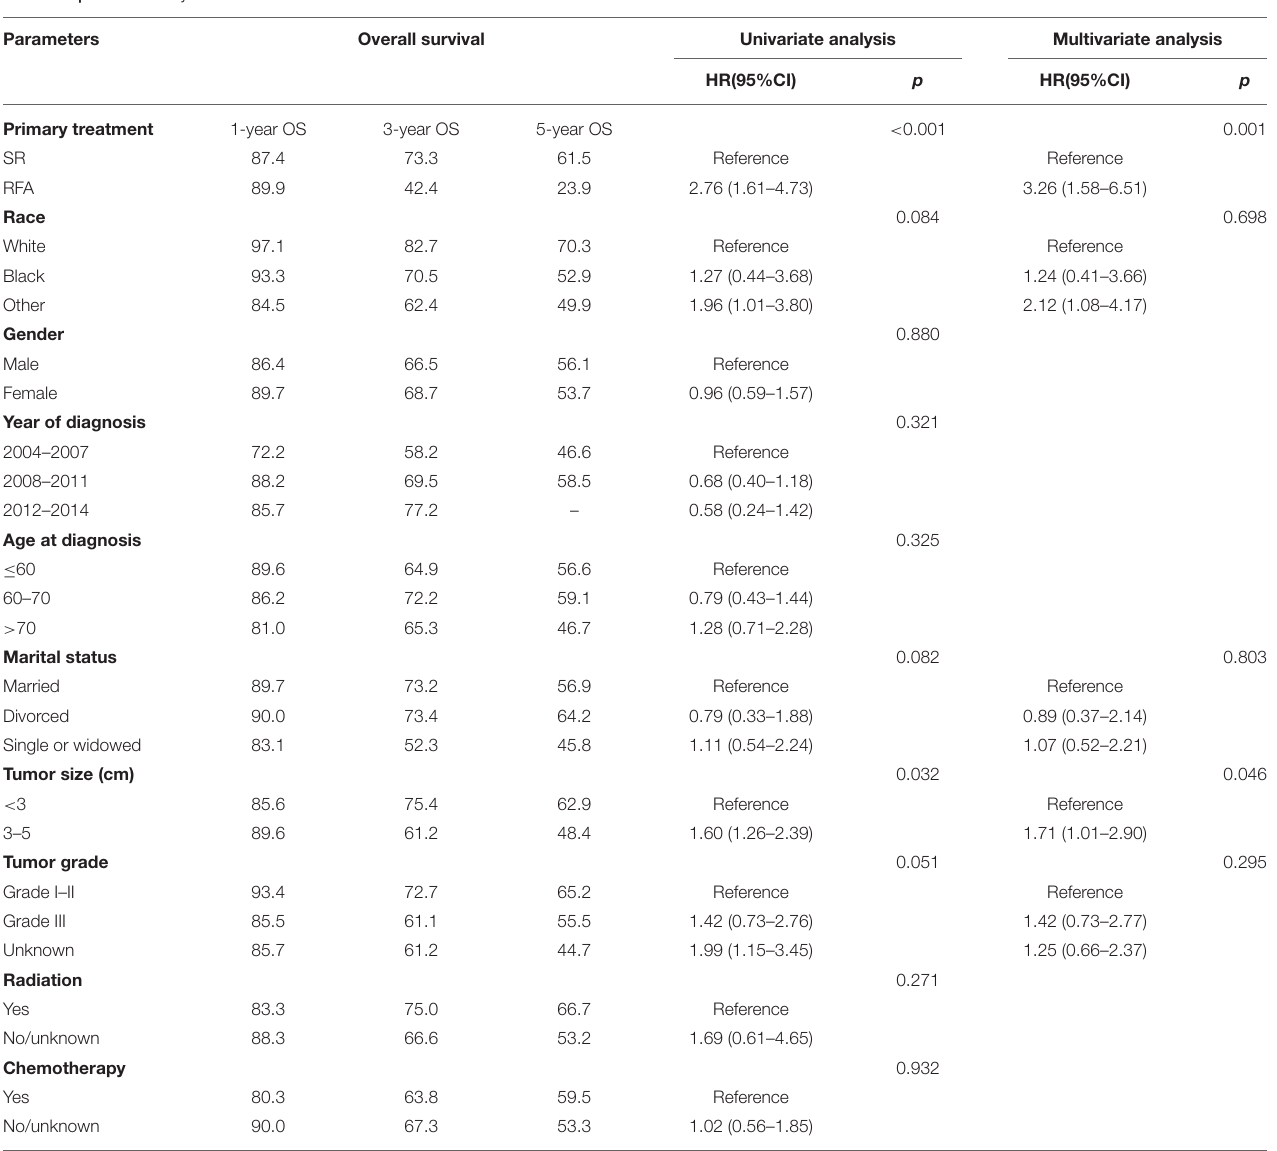
TABLE 2 | Survival analysis in terms of overall survival.